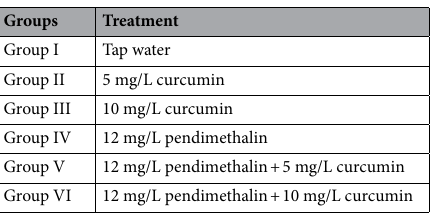
Table 1. Treatment